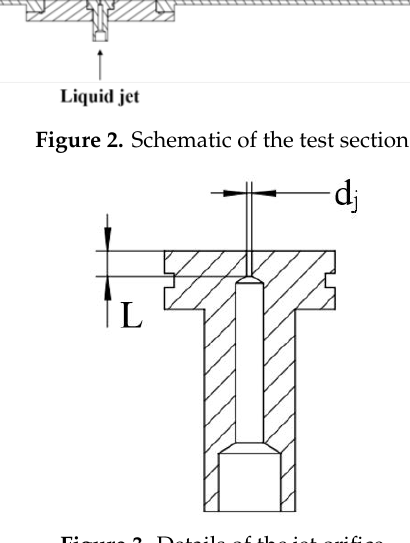
Figure 3. Details of the jet orifice.